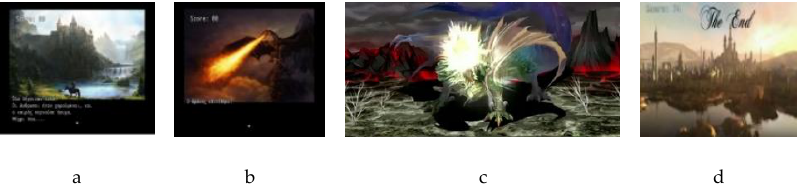
Figure 9. Game storyline: ( a ) The first screen of the introductory video presents the quiet life of the kingdom before the arrival of the evil dragon. ( b ) The arrival of the dragon brings fear and disaster.